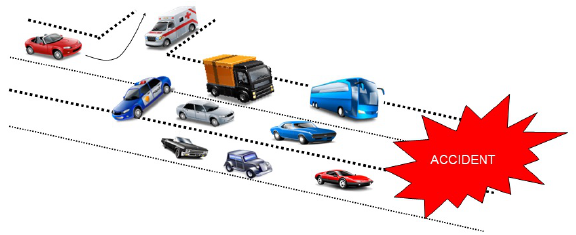
Figure 4. The broadcast storm problem may lead to safety- related service disruption after a road accident